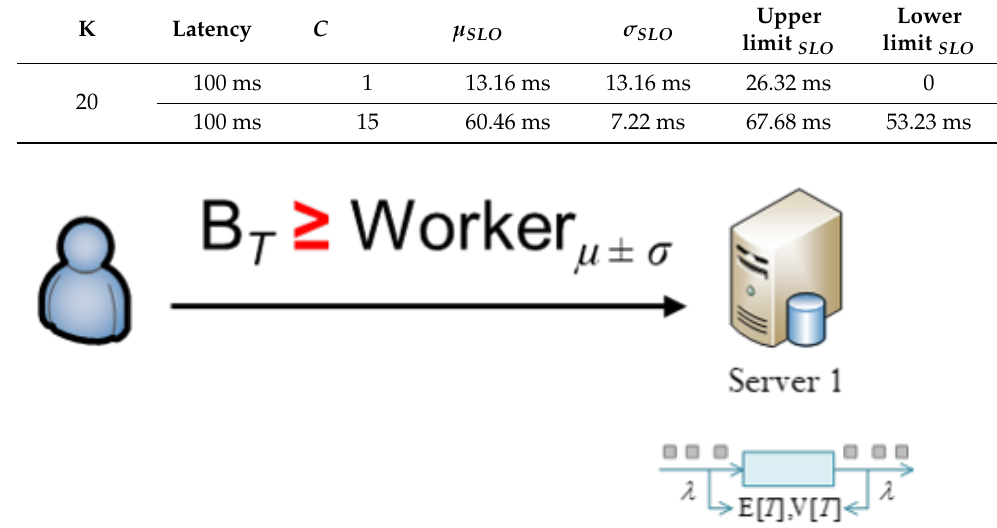
Figure 11. Using the translated budget to determine the right